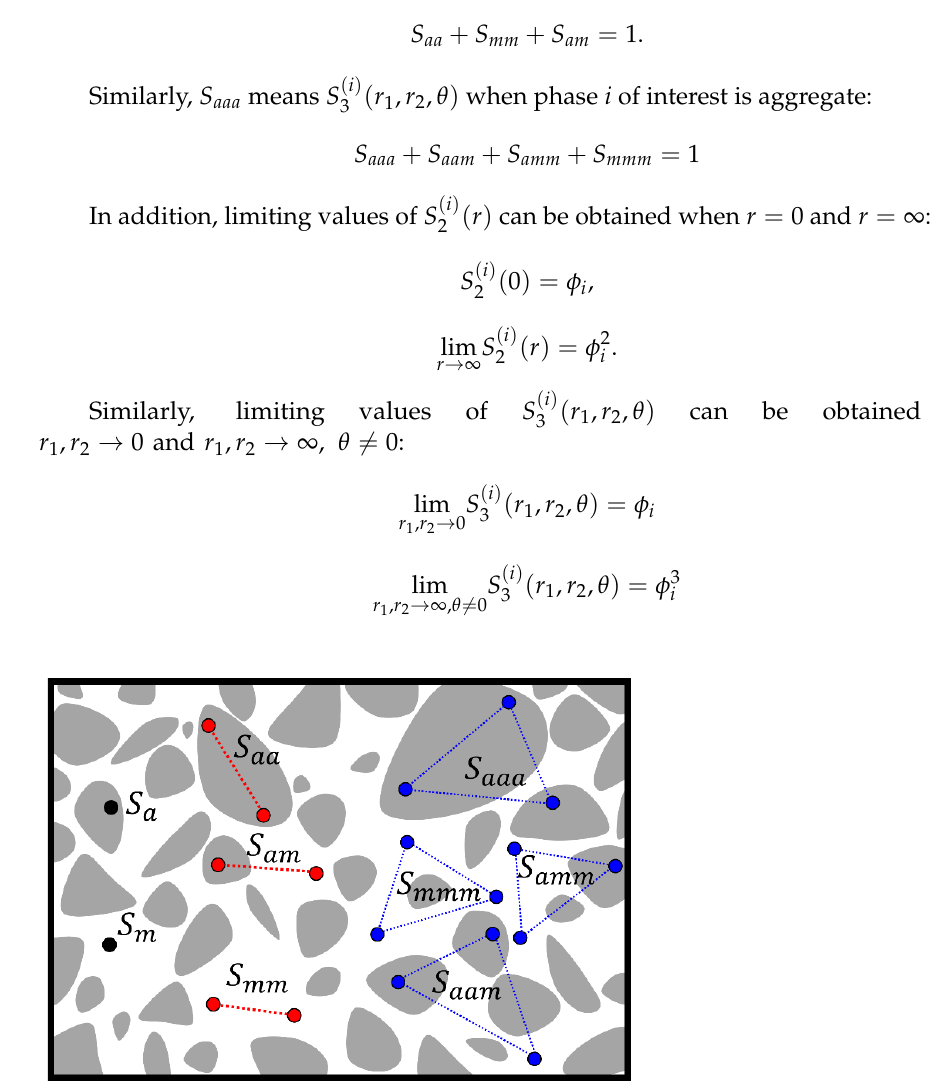
Figure 1. Illustration of one ‐ , two ‐ , and three ‐ point correlation functions.